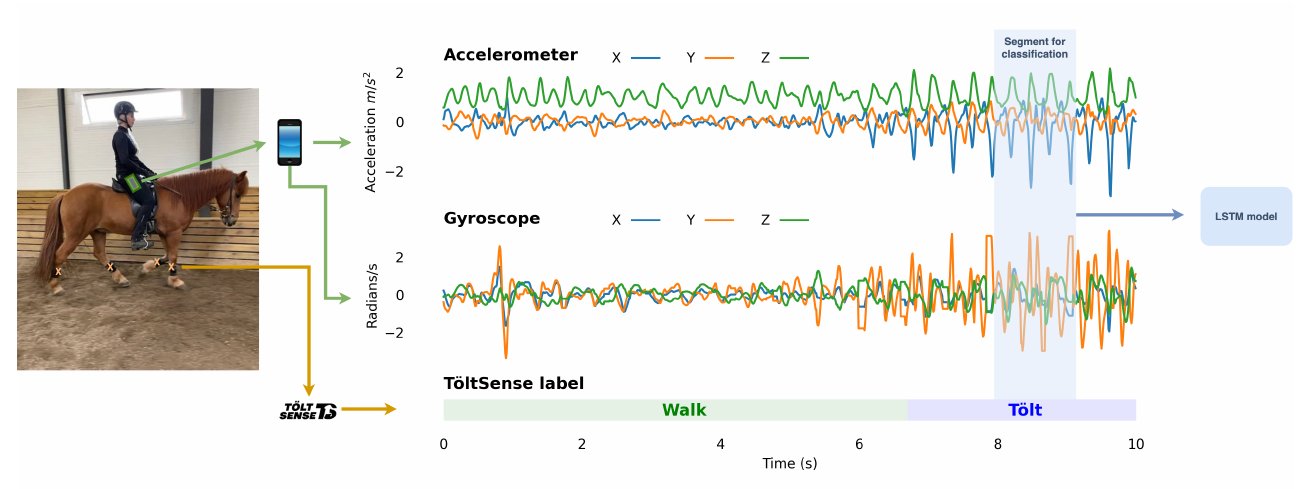
Figure 1. Data labelling with the TS application. The left panel shows the location of the sensors. The TöltSense sensors are strapped to the lateral aspect of the metacarpal/metatarsal bone, and the phone is placed in the rider’s pocket. The right panel shows the data from the mobile sensor after rotation to a given frame of reference (world-frame) and the gait labels as a horse switches from walk to tölt. The X and Y curves correspond to variations in the acceleration and gyroscope signal in the horizontal plane, and the Z curve corresponds to variations on the vertical axis. The sign of the signal on a given axis corresponds to the direction of the signal on that axis. The highlighted segment shows an example of the input we used for the Bi-LSTM